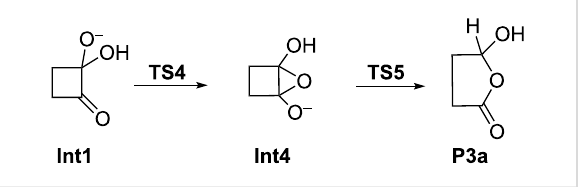
Scheme 5: Actual path C obtained by the calculations (as in Scheme 3, Int1 , TS4 , Int4 , and TS5 are hydrated by six water mole- cules; P3a is the ion-dipole complex with [OH(H 2 O) 5 ] – ).